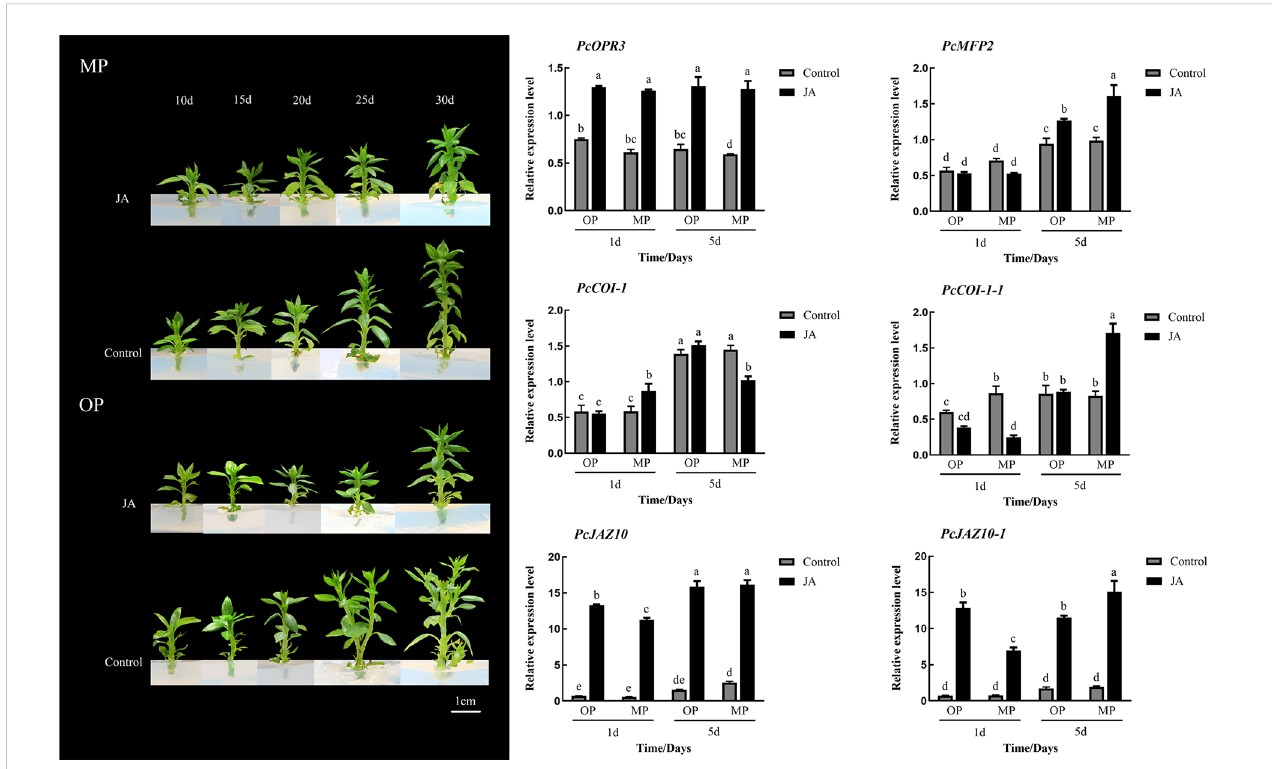
FIGURE 6 Effects of exogenous methyl jasmonate (JA) on plant phenotype and relative expression of six genes associated with the jasmonate signaling pathway at different stages of shoot development. Different lowercase letters above bars within a graph indicate a statistically signi fi cant difference (p < 0.05, Duncan ’ s multiple range test).